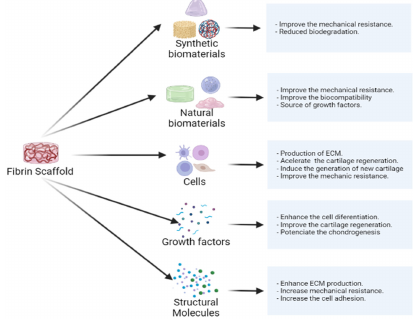
Figure 2. Summary of the advantages of fibrin as a scaffold. Characteristics and components that accompany fibrin scaffolding and promote the repair of chondral tissue.